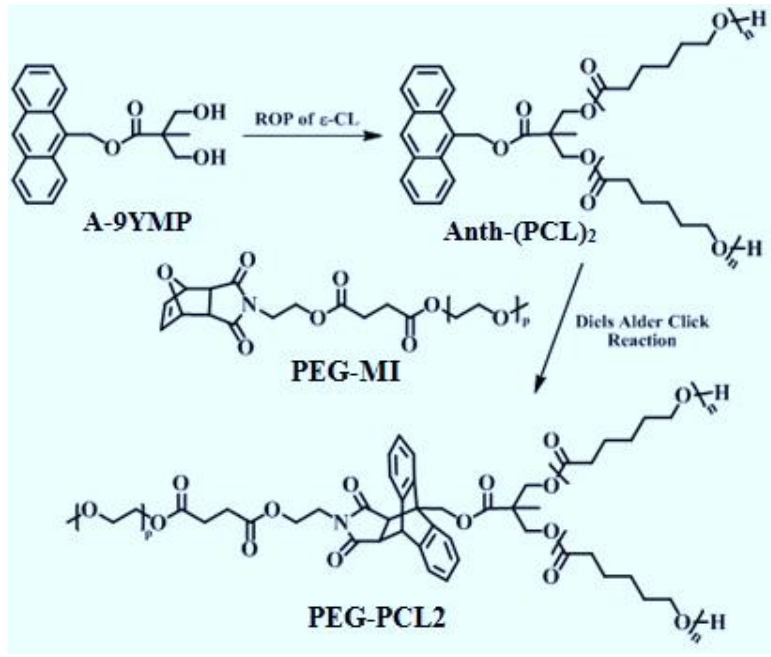
Figure 1. Synthesis of Y-shaped amphiphilic PEG-PCL 2 in order to prepare polymeric micelles. The figure is adopted from our previously published data [13]. Table 1. 1 H-NMR chemical shifts and multiplicities of the functional groups of PEG-PCL 2 in CDCl 3 , δ. Functional Groups